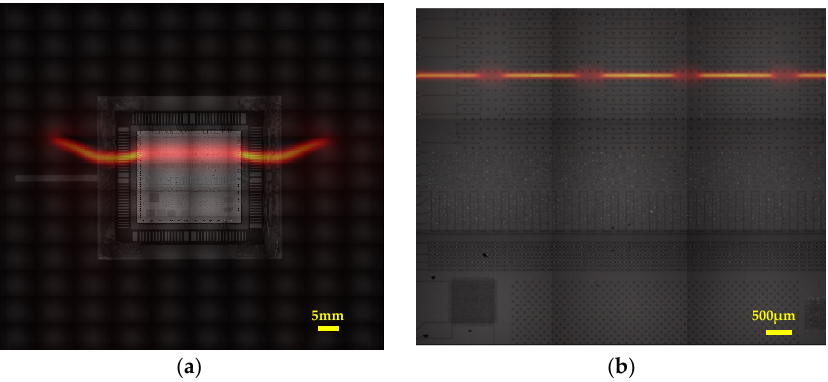
Figure 4. Overlays of the current images with the optical images: ( a ) SQUID AC scan; ( b ) GMR AC scan.